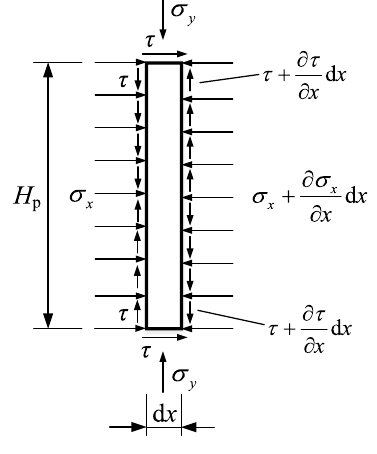
Fig. 4 Micro element mechanical model of the plastic